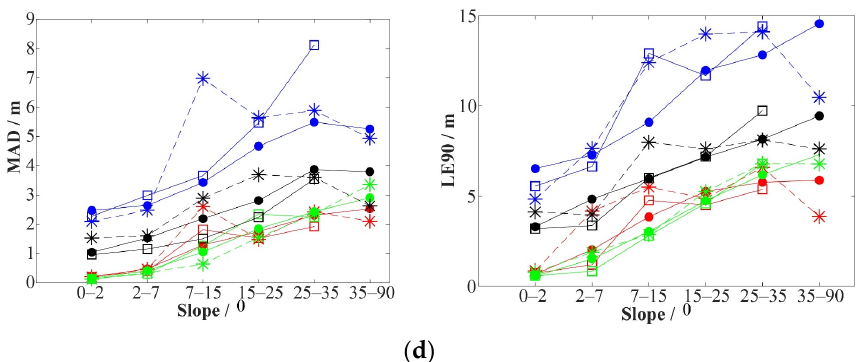
Figure 10. The relationship between quality indicators ((left) MAD and (right) LE90) and land cover in four study areas: ( a ) Sichuan; ( b ) Xinjiang A; ( c ) Xinjiang B; and ( d ) Inner Mongolia.